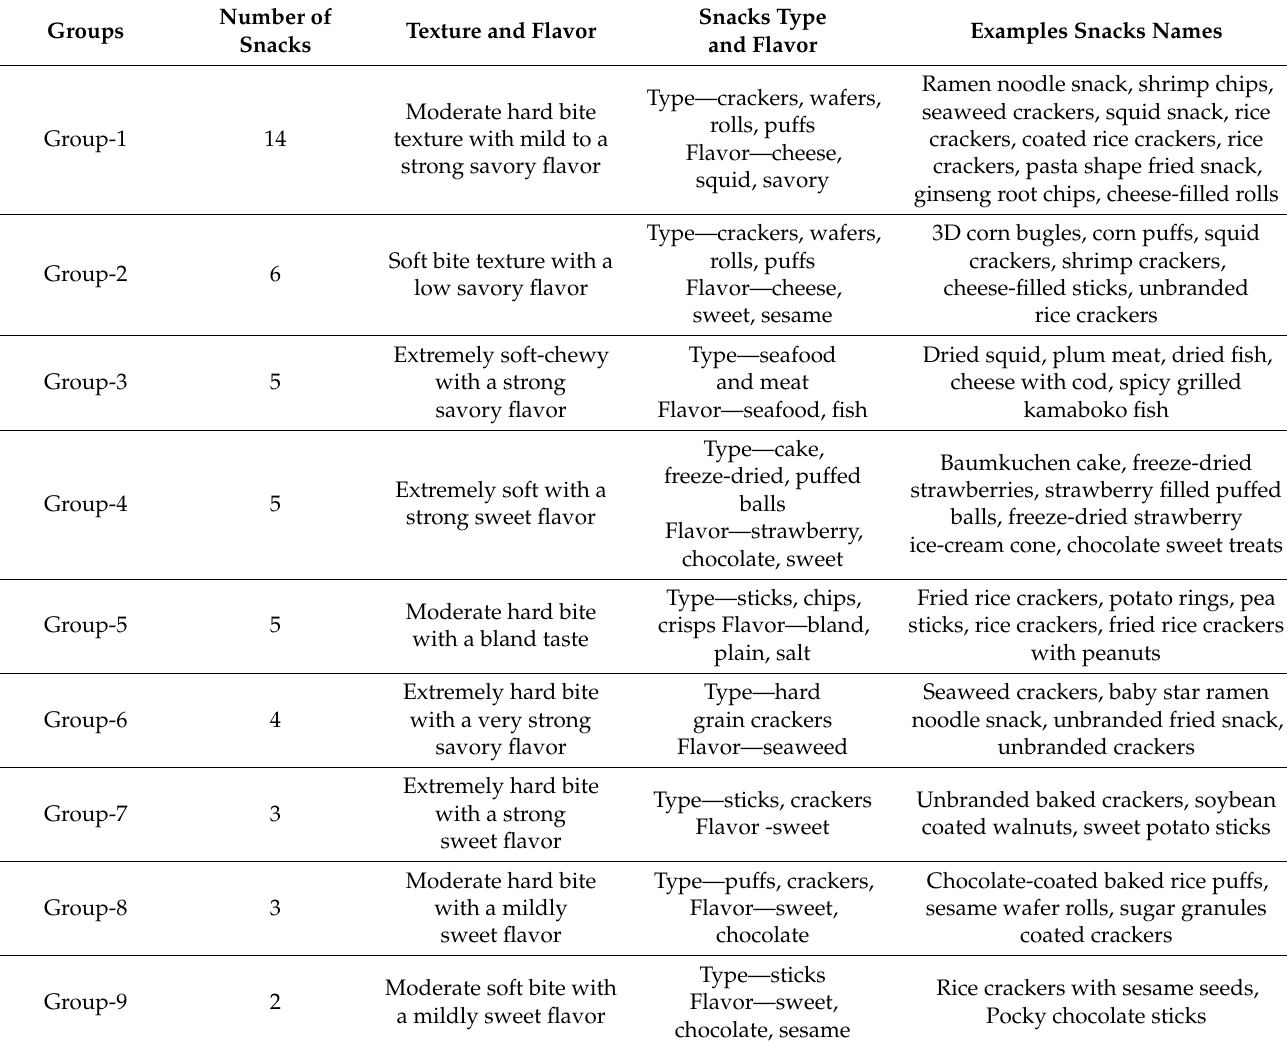
Table 3. Group identified in the projective mapping of the JP snacks. Group number, number of snacks in each group, texture, snack type, flavor, and snack